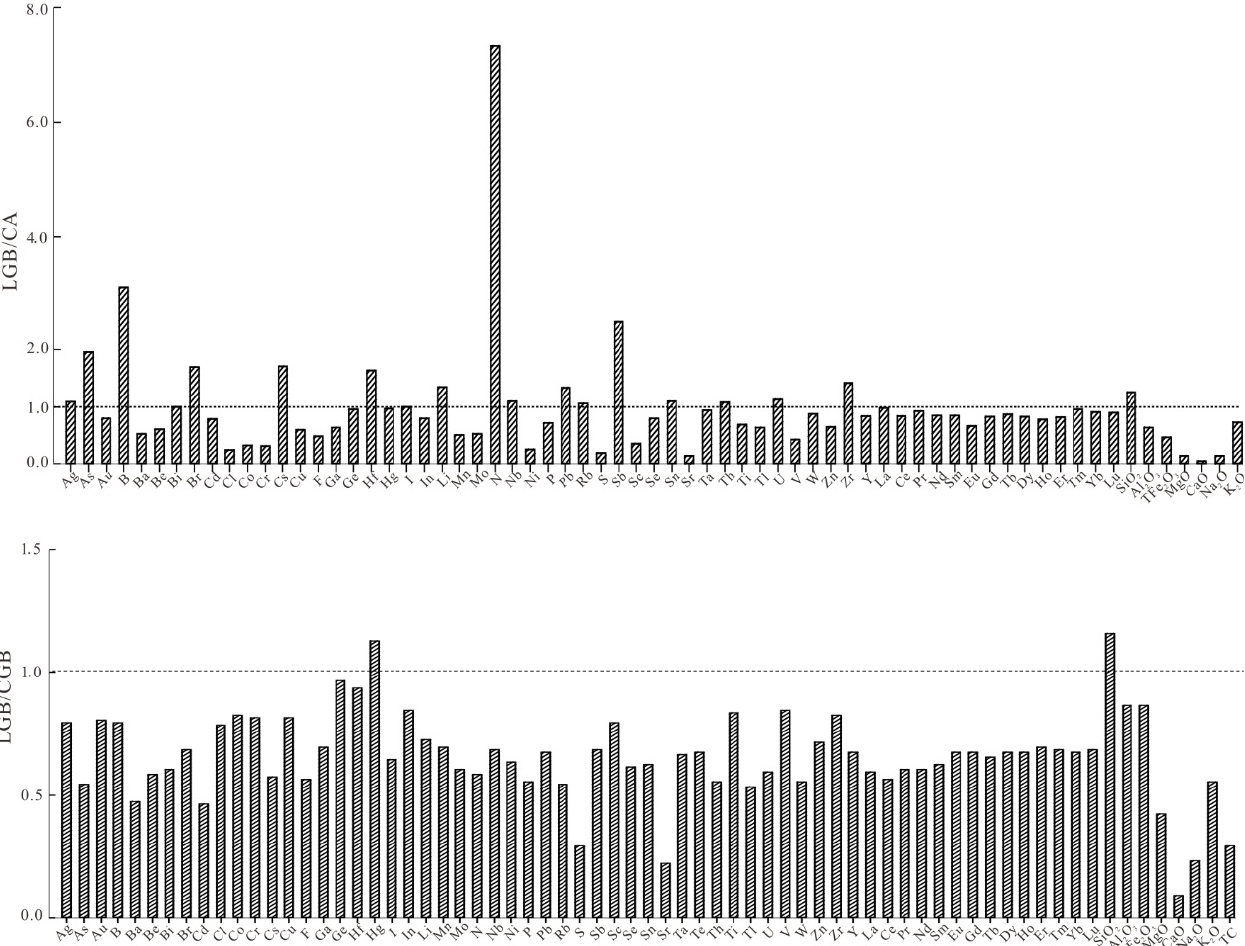
Figure 5. Bar graph showing the enrichment/depletion of the 69 elements using the ratio of the median and the CA ( upper ) and CGB ( top ) values.